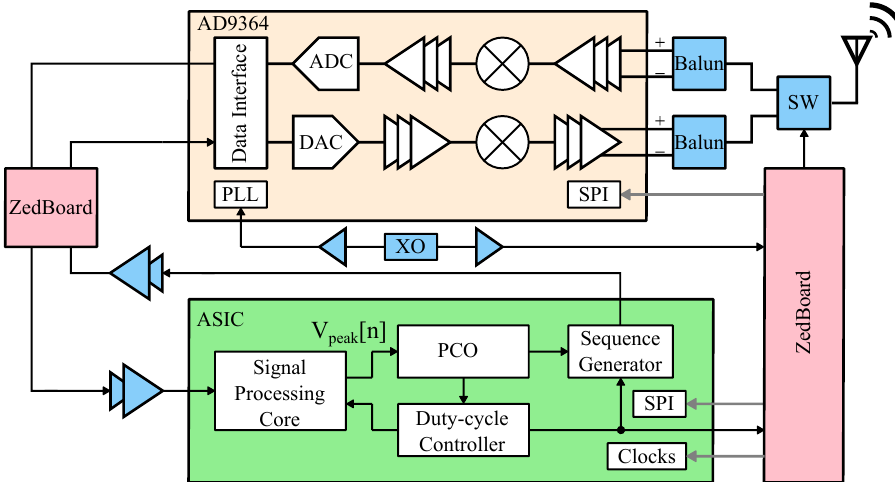
Figure 9. A functional block diagram of the peer-to-peer (P2P) radio node. AD9364 transceiver’s digital IO is routed to the ASIC chip for syncword detection and generation via PCB level-shifters. A shared crystal provides clock for the entire system. A ZedBoard is used to initialize the system and perform miscellaneous